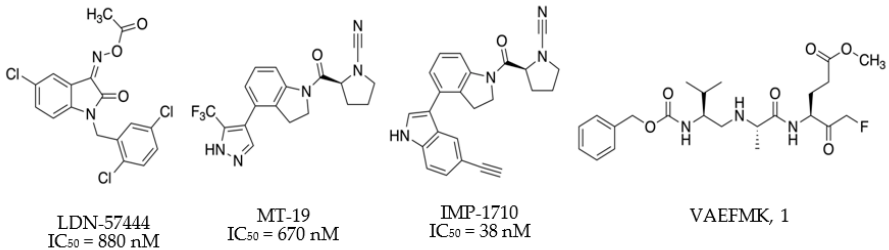
Figure 1. Previously reported UCHL1 inhibitors with biochemical IC 50 values versus UCHL1.